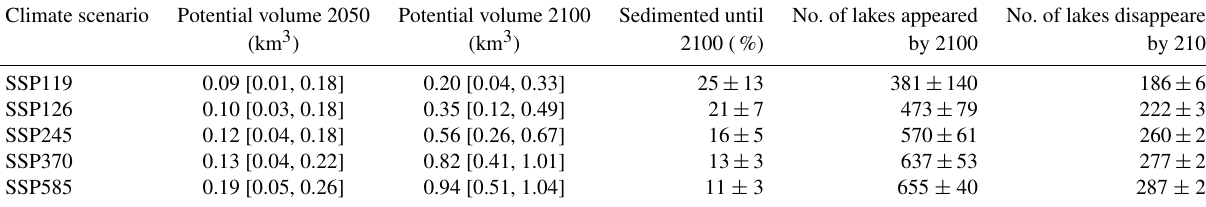
Table 2. Overview of the total potential lake volume anticipated to emerge by the years 2050 and 2100 when accounting for sedimentation (first two columns), the percentage of the total lake volume that might be lost because of sedimentation until 2100 (as % of the potential volume), as well as numbers of potential lakes appearing (because of glacier retreat) and disappearing (because of sedimentation) until the year 2100 (last two